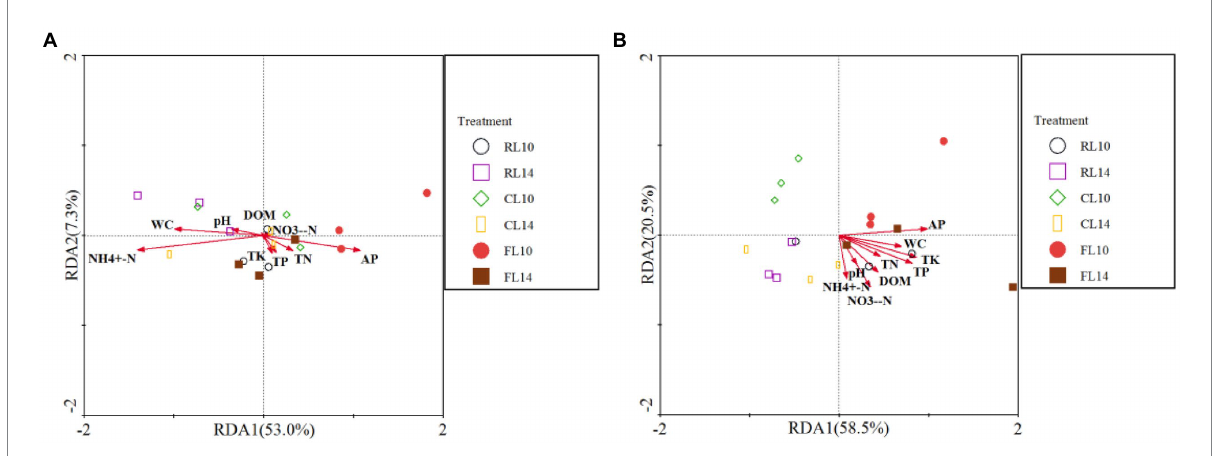
FIGURE 5 Redundancy analysis (RDA) of soil properties and bacterial functions. (A) is the R1 growth stage, (B) is the R6 growth stage.